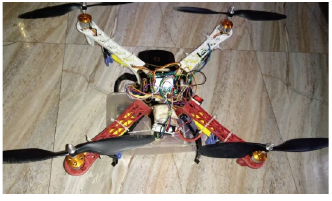
Figure 6. The implemented Drone with container attached